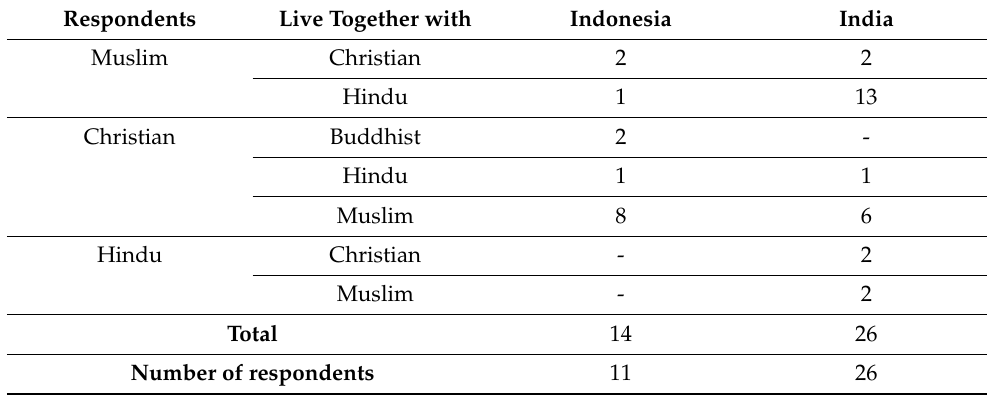
Table 7. Living together with family members of a different religion (Q8). Respondents Live Together with Indonesia India Muslim Christian 2 2 Hindu 1 13 Christian Buddhist 2 - Hindu 1 1 Muslim 8 6 Hindu Christian - 2 Muslim - 2 Total 14 26 Number of respondents 11